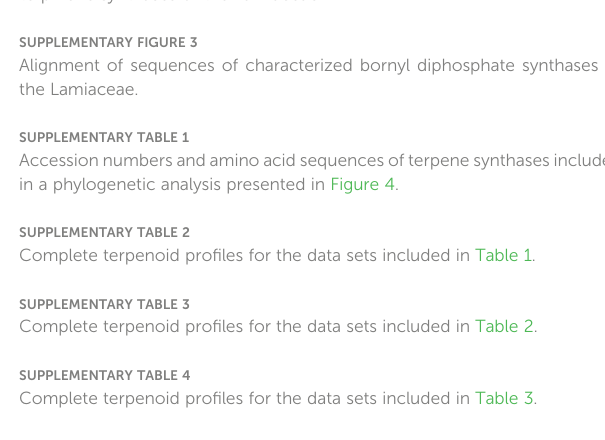
in a phylogenetic analysis presented in Figure